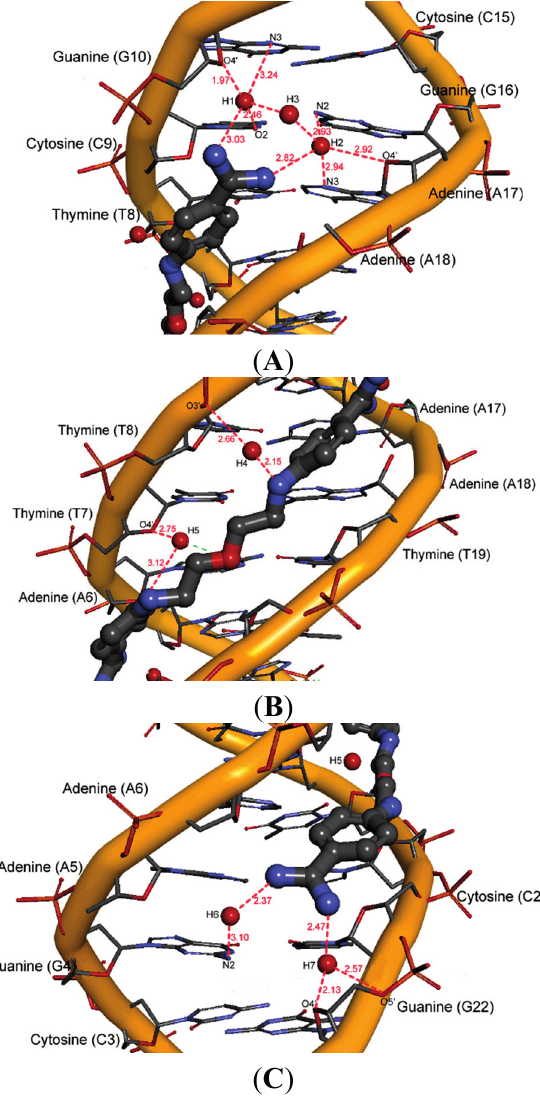
Figure 7. A view of hydration sites for compound 5 in the minor groove (red lines—hydrogen bonds; length [Å]). ( A ) hydration sites H1–H3; ( B ) hydration sites H4–H5; ( C ) hydration sites